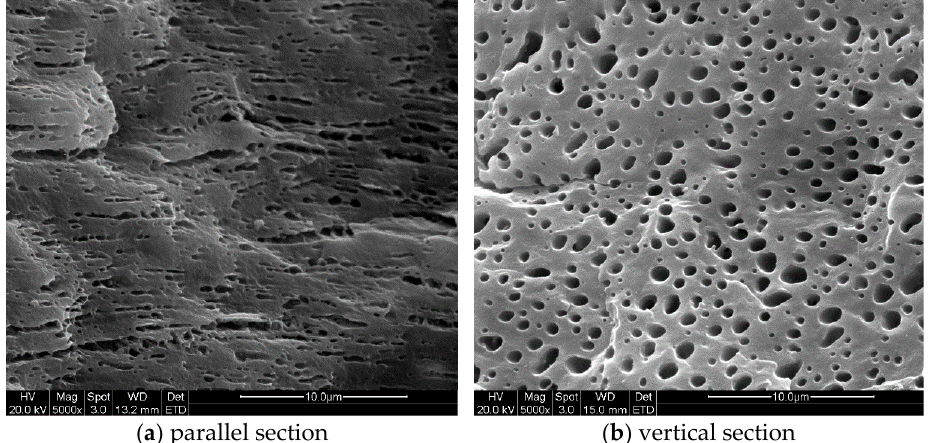
Figure 11. Morphologies of the droplets in shear layer at position (1) of case II part.